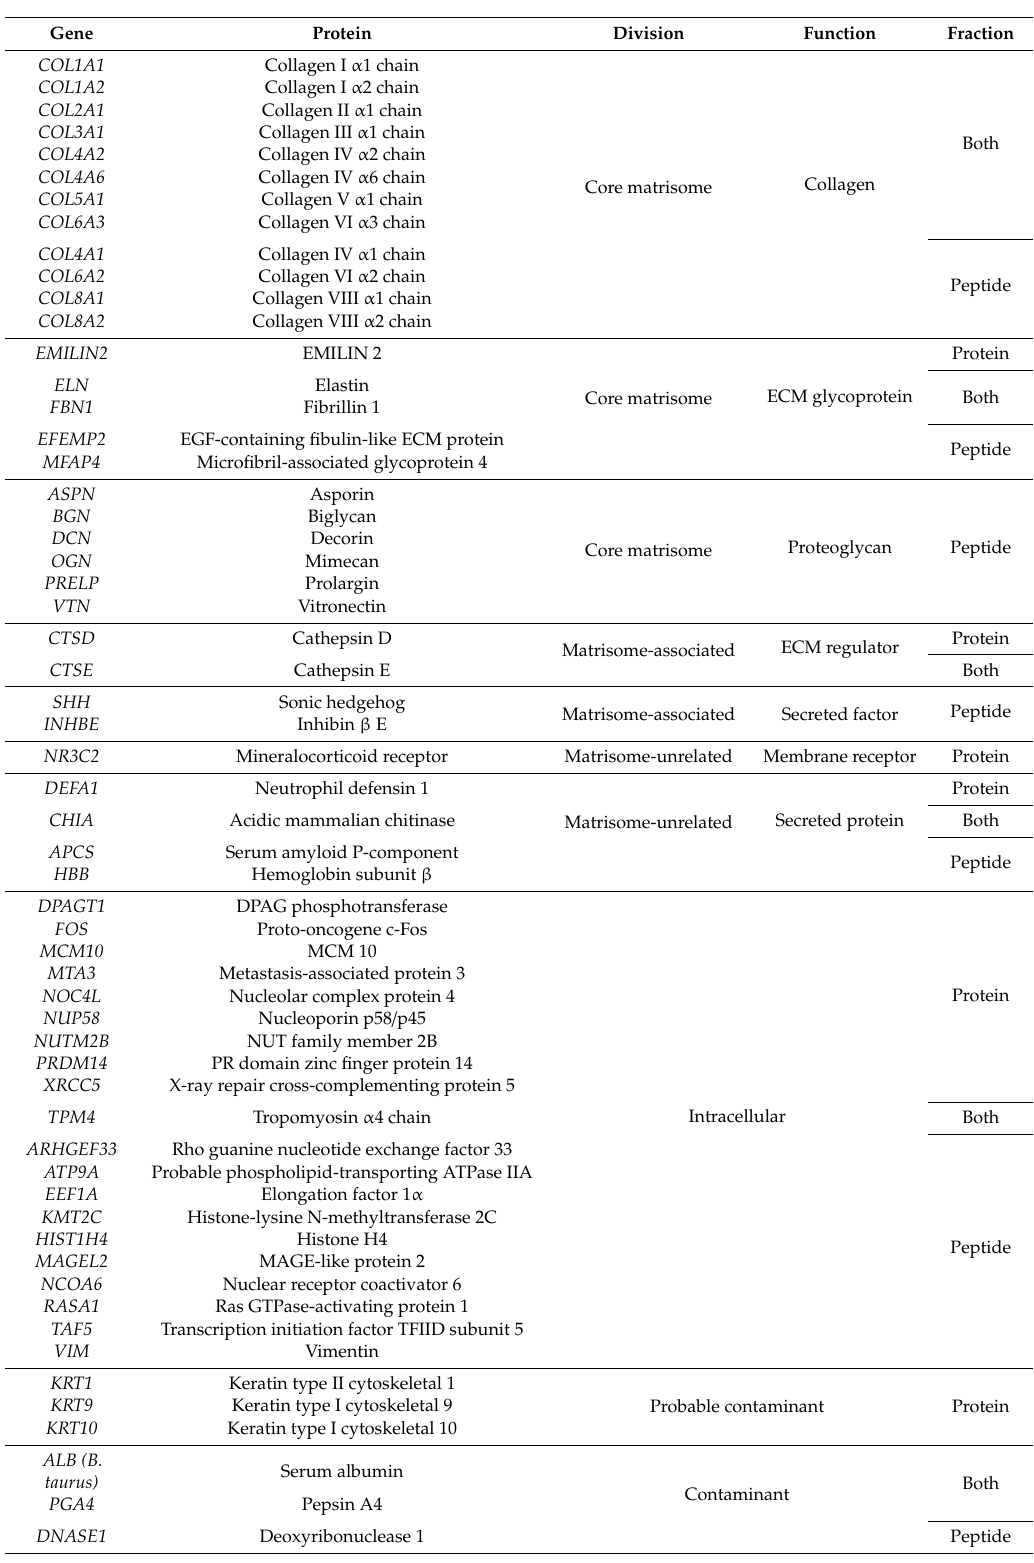
Table 1. Composition of solubilized HL-ECM. Summary of the proteomic analysis of solubilized HL-ECM: gene and protein name, classification according to the Matrisome project, fraction where the protein was